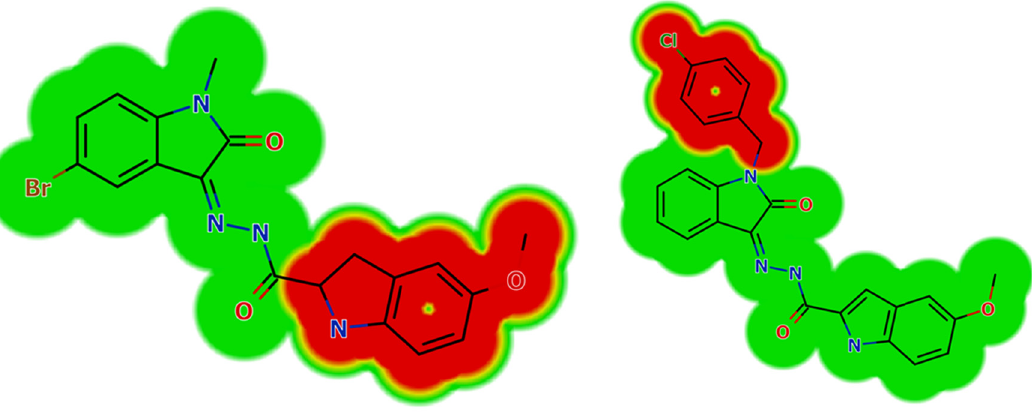
Figure 9: Structural alert ( halogenated benzene ) for M1 and compounds 2 , 3 and 6 giving rise to hepatotoxicity and nephrotoxicity, respectively, using DEREK software. ( M1 showed hepatotoxicity due to 4 - aminophenol part, while compounds 2 , 3 and 6 showed nephrotoxicity due to the halogenated benzene moiety labeled with red color using the DEREK module of StarDrop software )